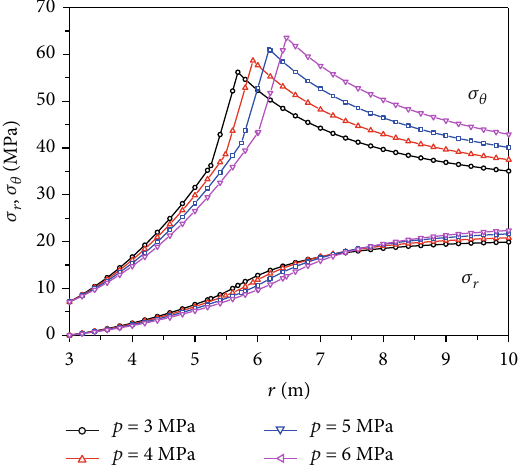
Figure 6: Comparison of stress distribution at the tunnel crown based on di ff erent pore water